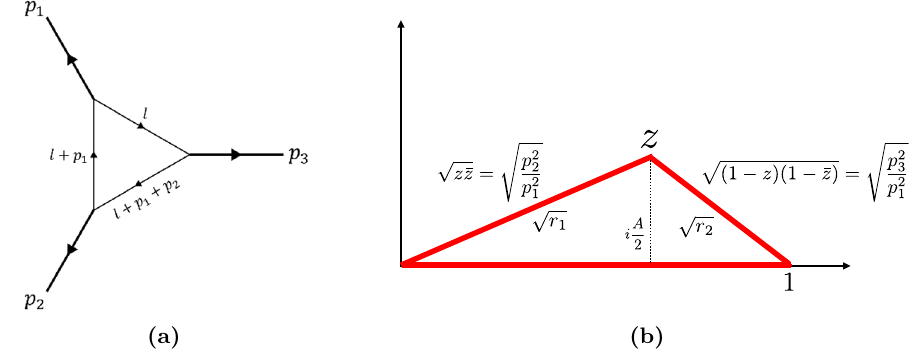
Figure 5. (a) Three mass triangle. (b). Corresponding dual geometry of the EEEC. The angles of the EEEC are mapped to the external masses of the three mass